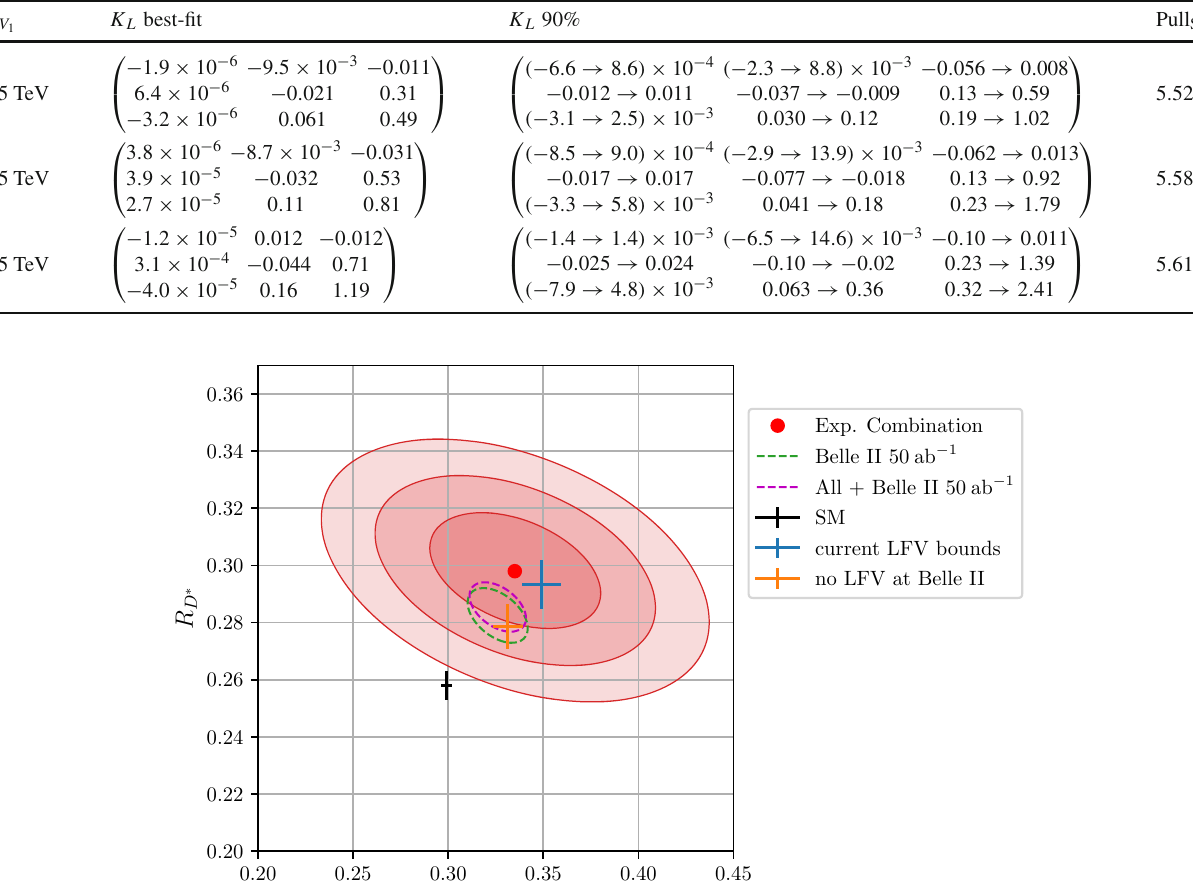
Table 5 Best-fit points, symmetric 90% ranges (see Appendix A for details) and SM pulls of the fits containing the envisaged sensitivities of the Belle II, COMET, Mu2e, Mu3e and MEG II experiments where the non-observation of all included cLFV observables is assumed